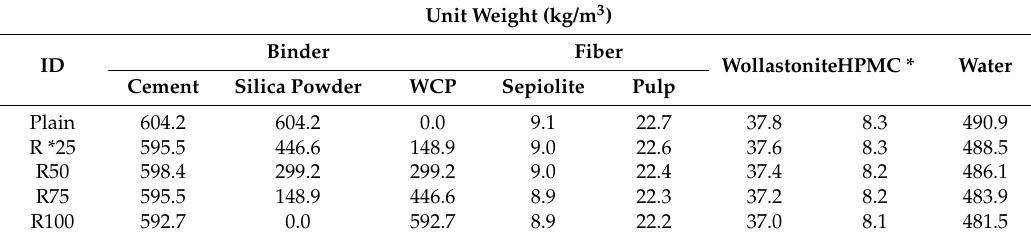
Table 4. Mixture